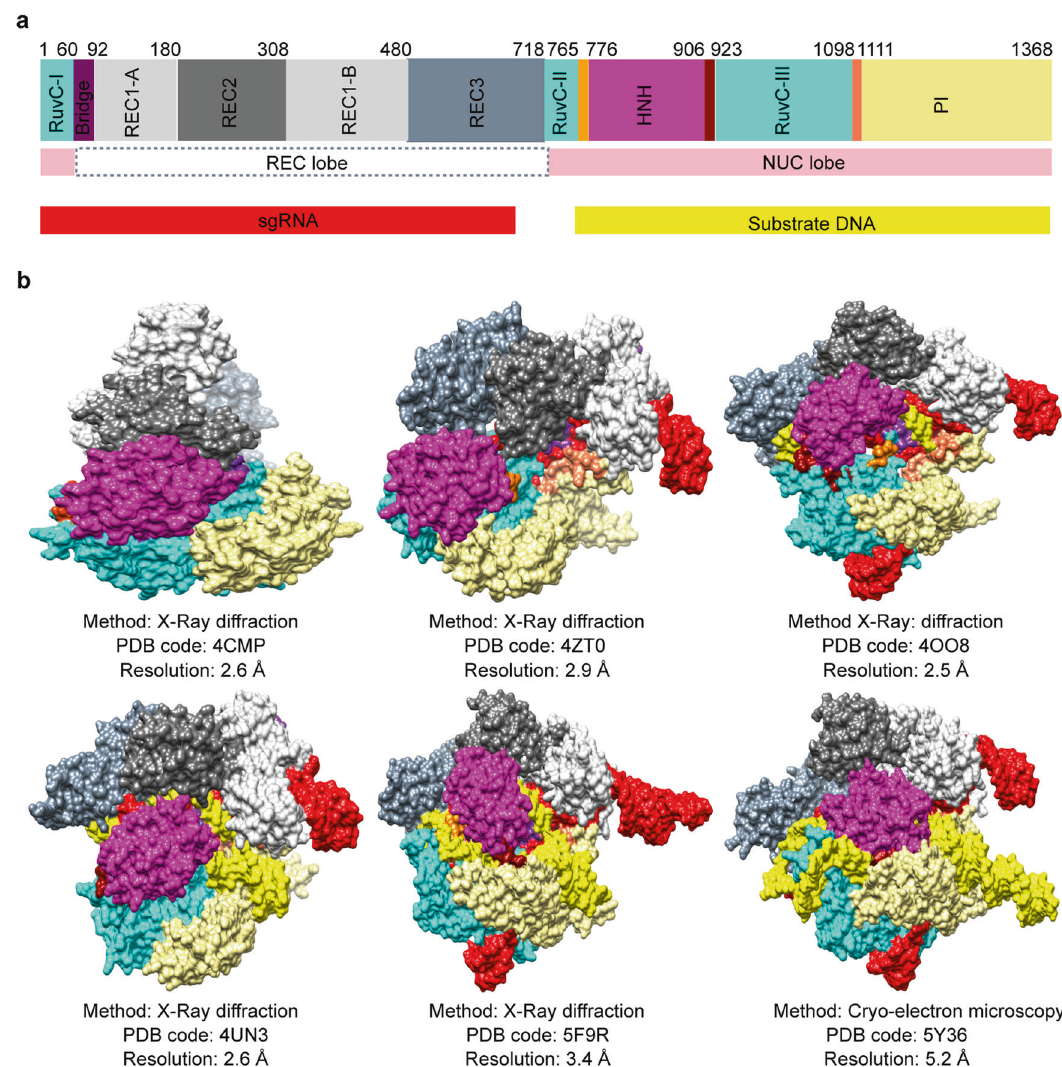
Fig. 1 Structures of CRISPR-Cas9 at different states. a Domains of the Cas9-sgRNA-DNA ternary complex are marked by different colors. Cas9 contains 1368 amino acids. b The structures are determined by X-ray diffraction or Cryo-electron microscopy, including Cas9 monomer (PDB ID: 4CMP), Cas9-sgRNA binary complex (PDB ID: 4ZT0), and Cas9-sgRNA-DNA ternary complexes (PDB IDs: 4OO8, 4UN3, 5F9R,